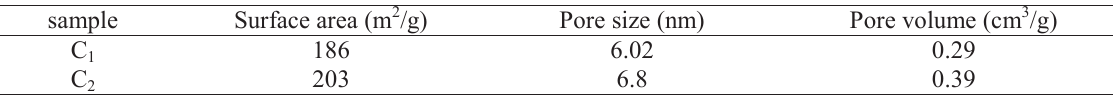
Table1. Textural properties for C1 and C2